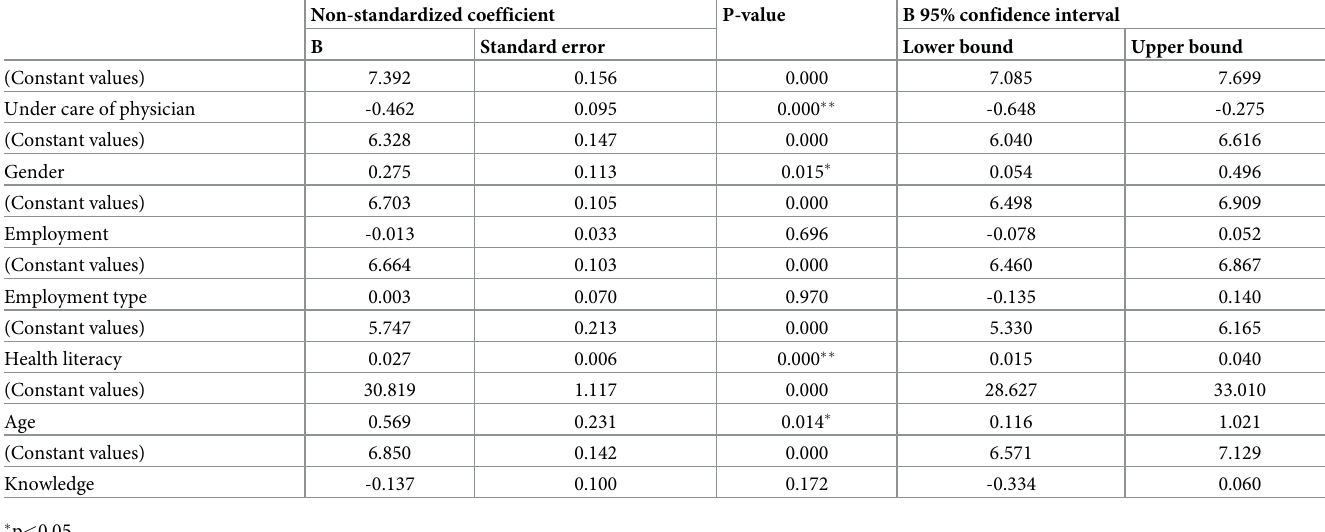
Table 5. Univariate linear regression analysis of preventive action, predictive